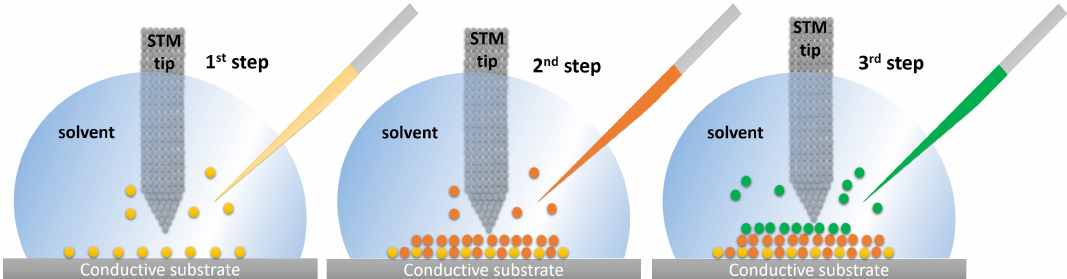
Figure 1. Schematic representation of a stepwise building of supramolecular structures by STM at the solid/liquid interface. Each step corresponds to one molecule or molecular system which can be added individually and monitored by high-resolution imaging. The experiments occur inside a drop of a high boiling point solvent which is added on the top of a conducting substrate and allows the phased addition of